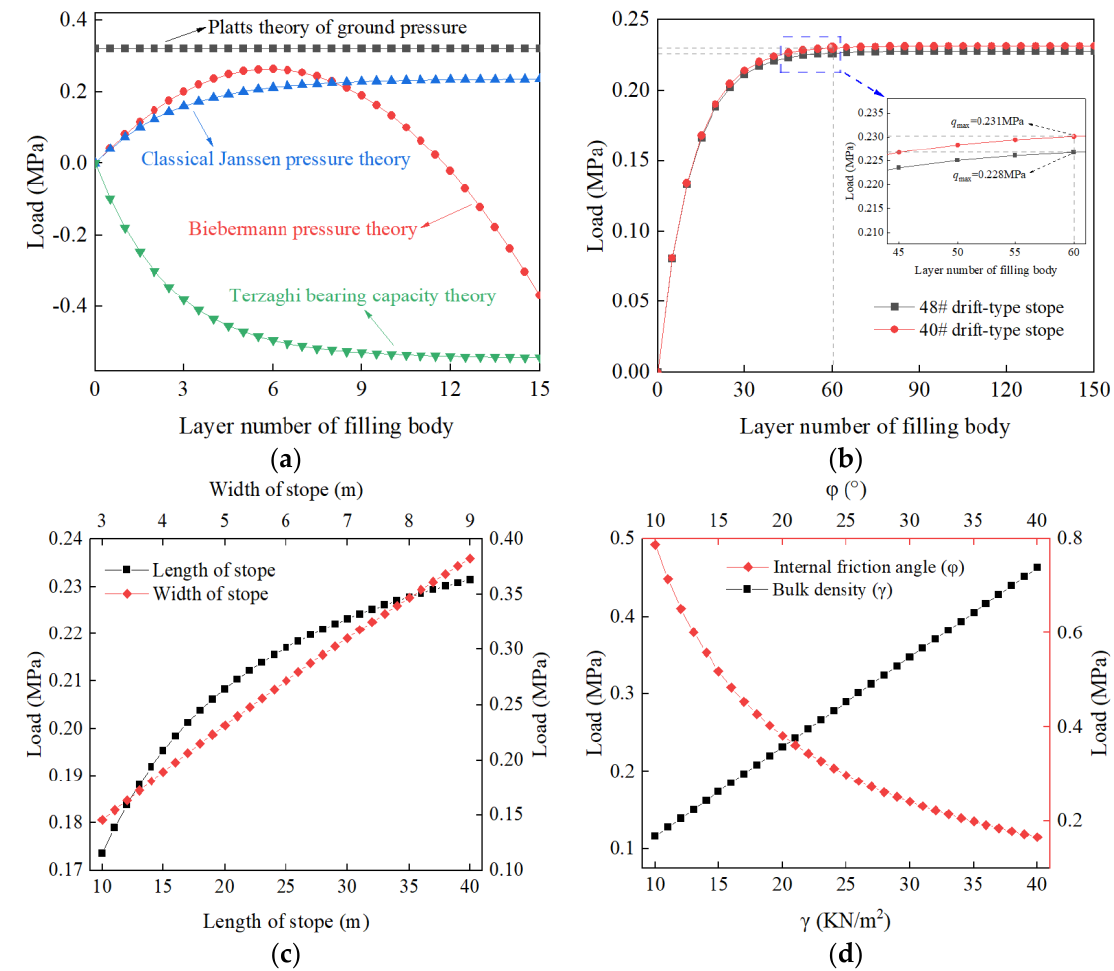
Figure 5. Results of load calculation: ( a ) comparison of each theory, ( b ) calculation results of experimental stopes, ( c ) effect of stope size on load, ( d ) effect of physical and mechanical parameters of the filling body on load.